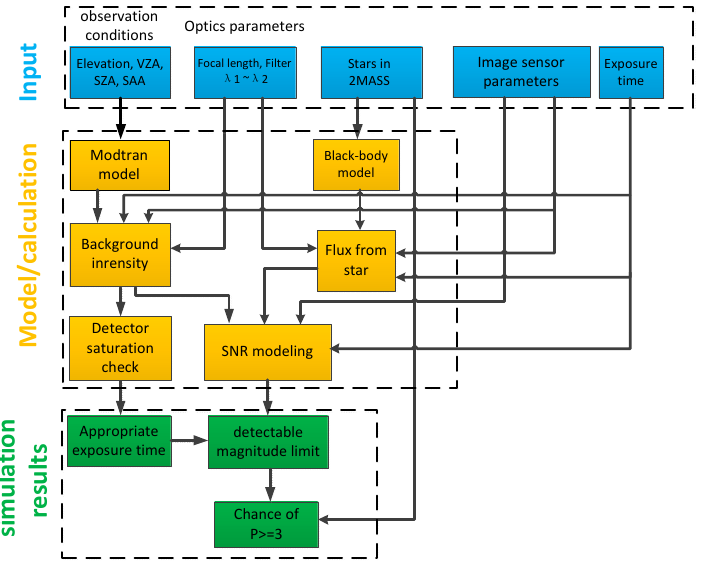
Figure 1. The design flow of All-Time star sensor detection